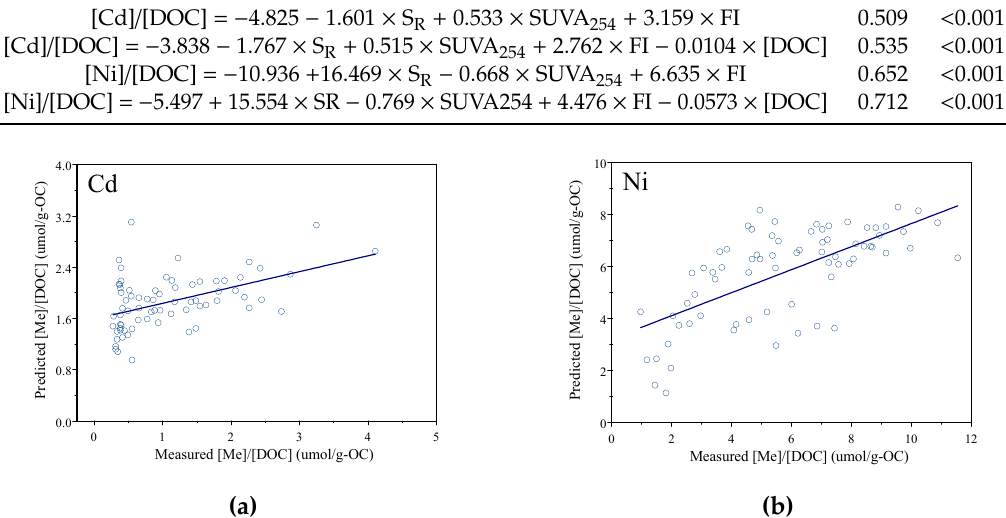
Figure 1. The linear relationship of the measured [Me] / [DOC] ratio and predicted [Me] / [DOC] ratio using the selected indicators for Cd ( a ) and Ni ( b ).